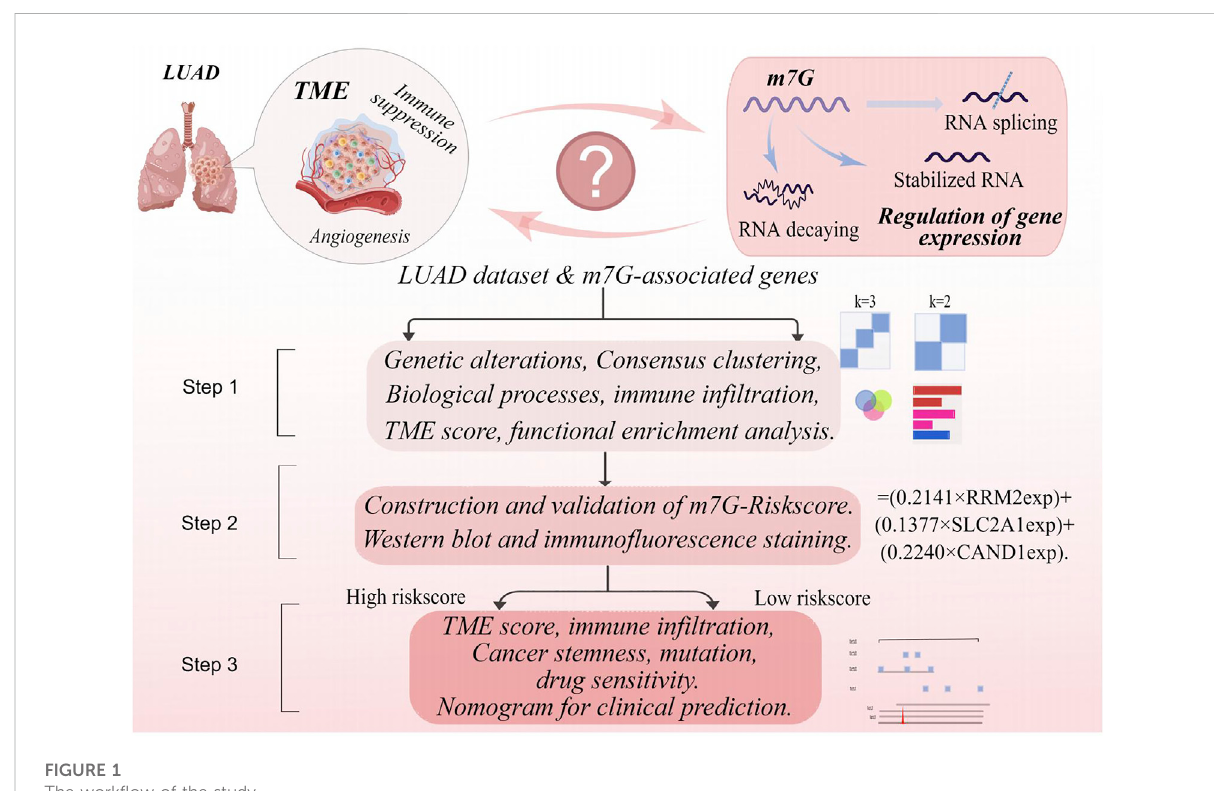
FIGURE 1 The work fl ow of the